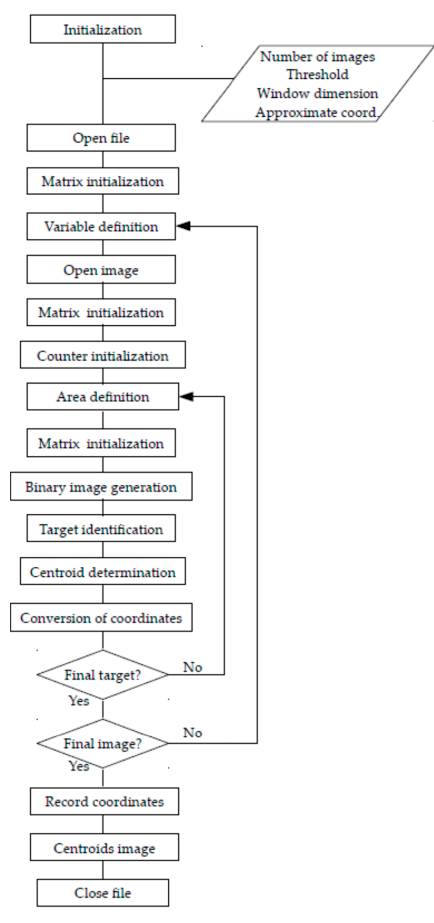
Figure A1. Digital image processing algorithm.